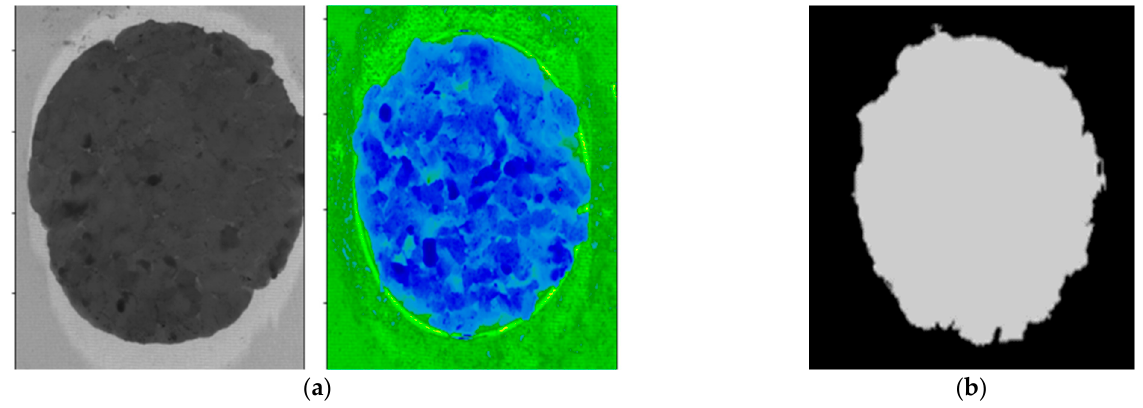
Figure 5. ( a ) A hyperspectral (greyscale and spectral) image of a pure beef burger patty; ( b ) A binary mask image created using thresholding at 952 nm with a value of 1.1.